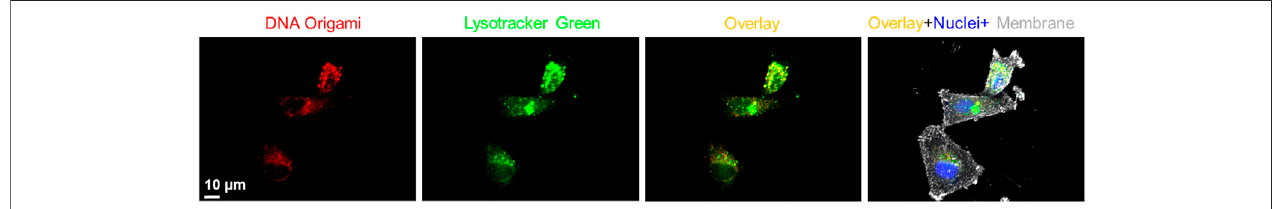
FIGURE 5 | Fluorescence co-localization of DNA origami fl uorescence (red) and a well-known lysosome marker, lysotracker green, showed signi fi cant localization of DNA nanostructures in the lysosomal compartments. Cell nucleus and membrane were stained with Hoechst ® 33342 (blue) and wheat germ agglutinin, AF633 conjugate (grey), respectively.